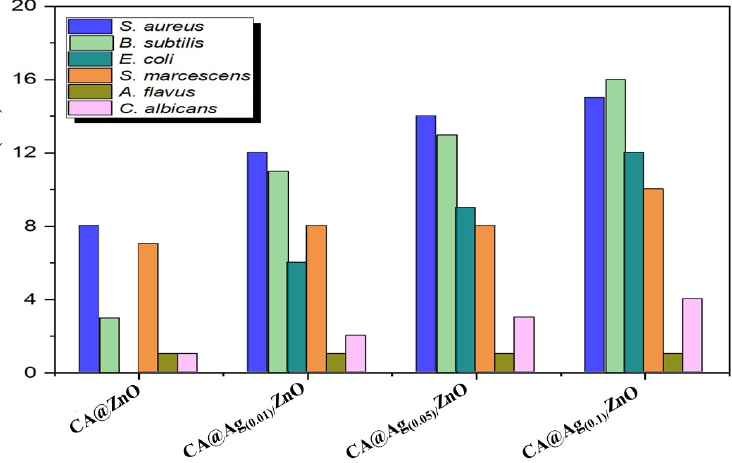
Figure 7. Antimicrobial activities of CA/ZnO and CA@Ag (0.01, 0.05, 0.1) /ZnO hybrid materials in the presence of selected microorganisms.